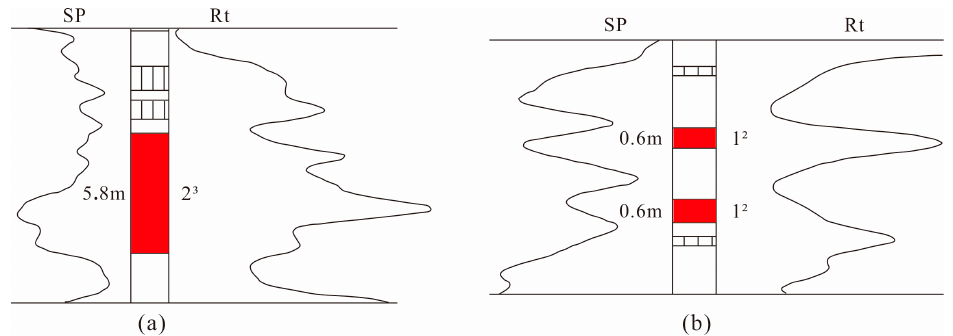
Figure 9. Identification standard of bar sand and beach sand on well log. ( a ) Bar sand in Well Fan142-4-2; ( b ) beach sand in Well Gao891-1.